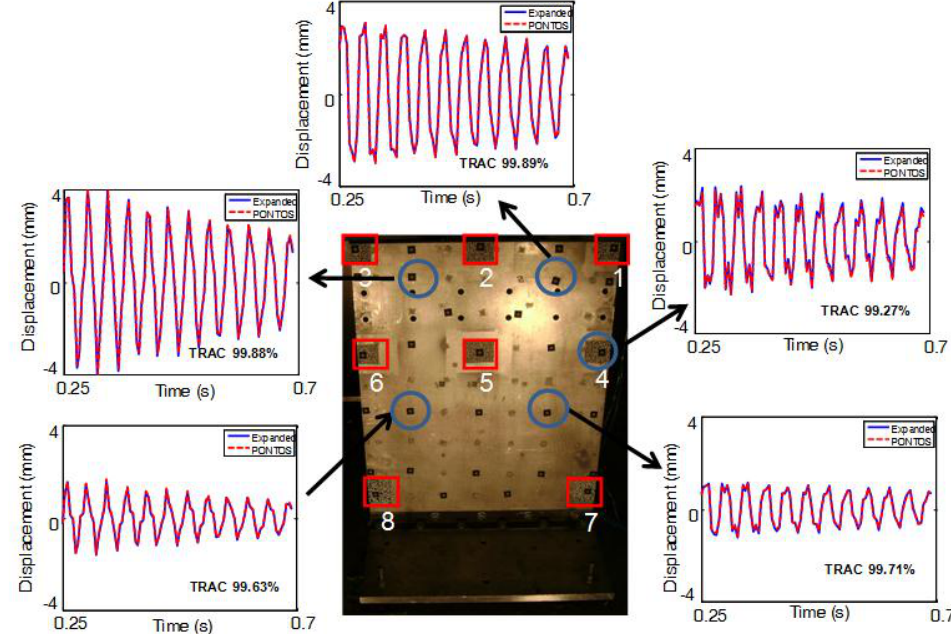
Fig. 13. Overlay of the displacement responses from predicted solution using first five modes for expansion and PONTOS at five different locations; expansion performed using sensor configuration 2.